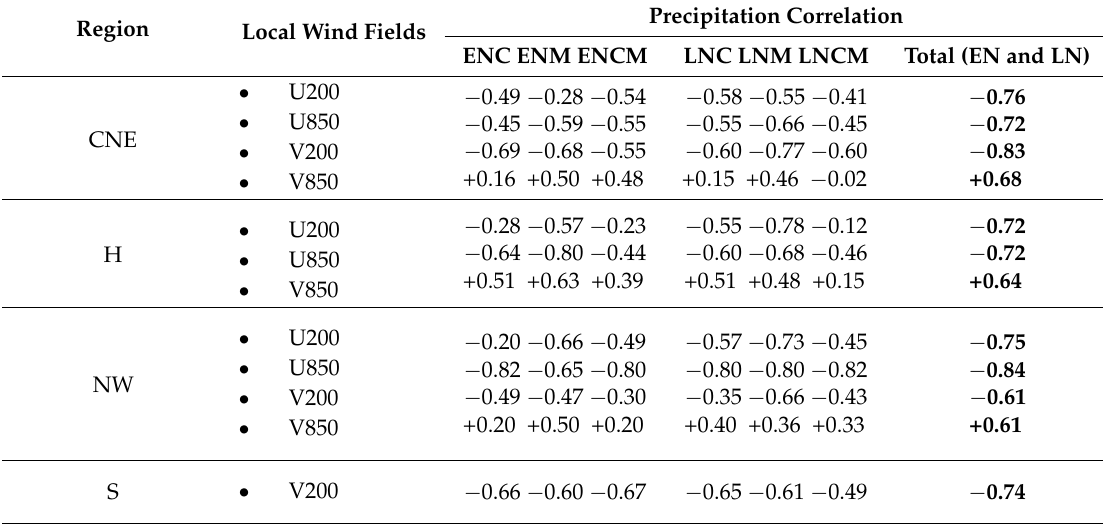
Table 3. Correlation of regional ISM precipitation with local wind fields in different ENSO phases.